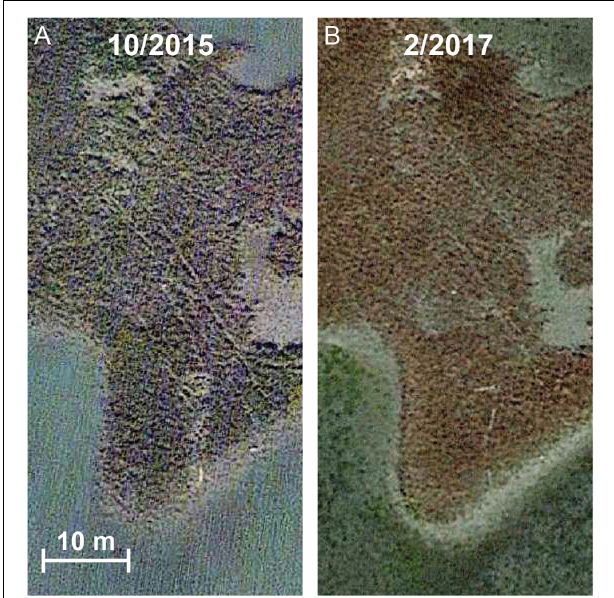
FIGURE 1 | Vegetation sampling transects conducted in 2015 (A) in a North Carolina saltmarsh that are still visible in 2017 (B) . Imagery obtained